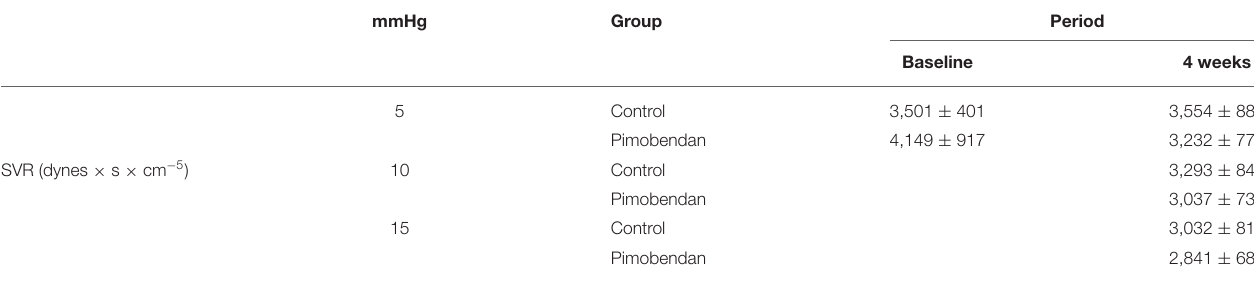
TABLE 2 | Systemic vascular resistance when central venous pressure is postulated to be 5–15 mmHg.